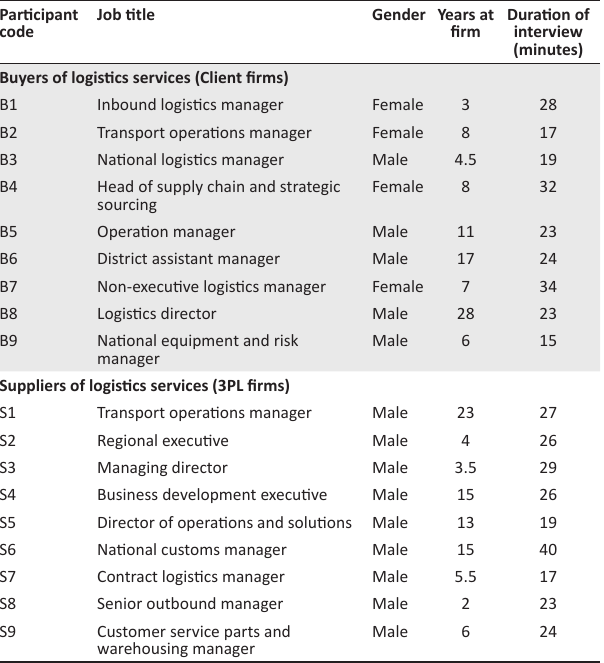
TABLE 1: Profile of study